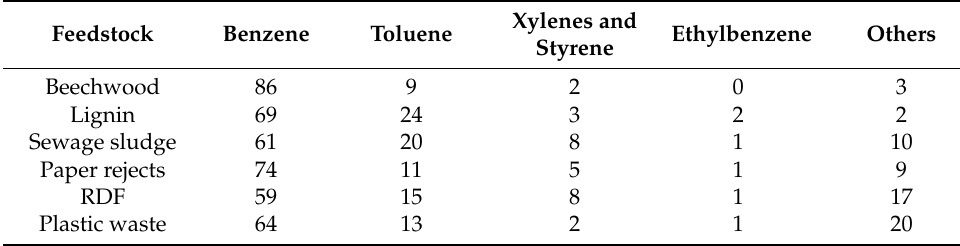
Table 6. Characterization of the collected BTX samples